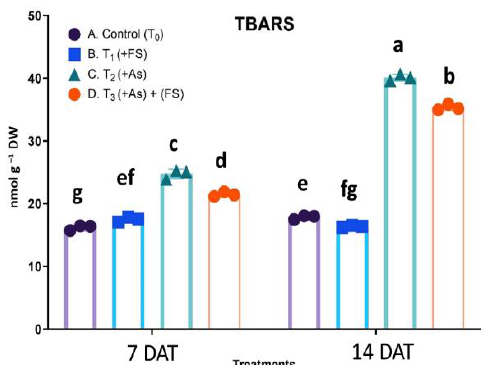
time points, indicating lesser oxidative stress (Figure 5).